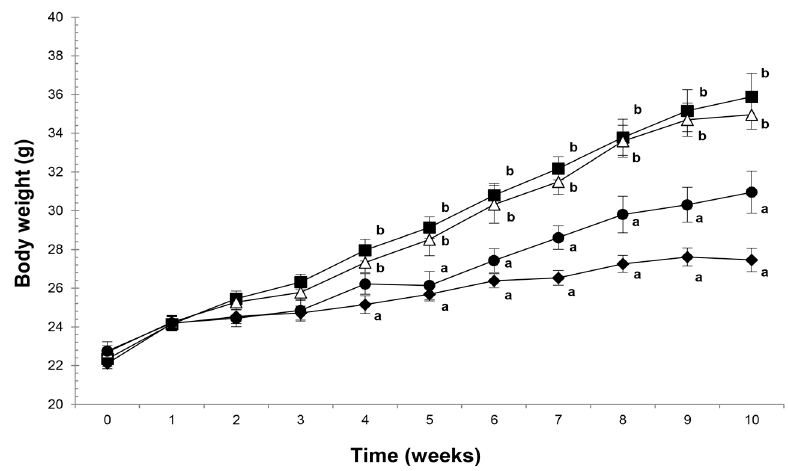
Figure 1. Body weights in mice fed with standard diet (SD, ⧫ ); high fat diet (HFD, ∎ ); high fat diet with agave fructans 5% (HFD/A5, ∆ ); high fat diet with agave fructans 10% (HFD/A10, ● ). One-way ANOVA with repeated measures and Tukey contrasts were performed to compare differences among groups. The data are represented as the mean with their standard errors of the mean (SEM). N = 10. Mean values with unlike letters (a,b) were significantly different ( p < 0.05).